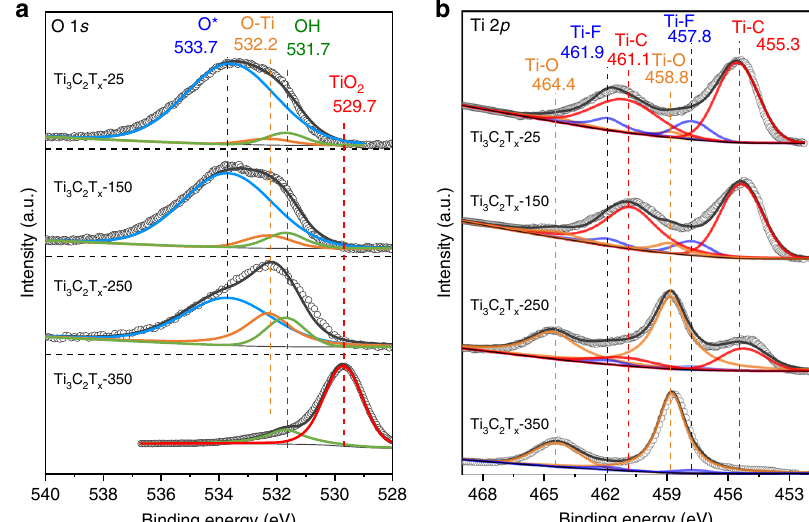
Fig. 2 XPS spectra of the obtained samples. a O 1 s and b Ti 2 p XPS spectra for Ti 3 C 2 T x -25, Ti 3 C 2 T x -150, Ti 3 C 2 T x -250, and Ti 3 C 2 T x TiO 2 , respectively 32 . The presence of surface OH groups was further con fi rmed by diffuse re fl ectance infrared Fourier trans- form (DRIFT) measurements (Supplementary Fig. 6). Surface- adsorbed oxygen species was considered as the physical adsorption. Thus surface hydroxyl groups and surface O-Ti species were regarded as the covered oxygen on the surface.